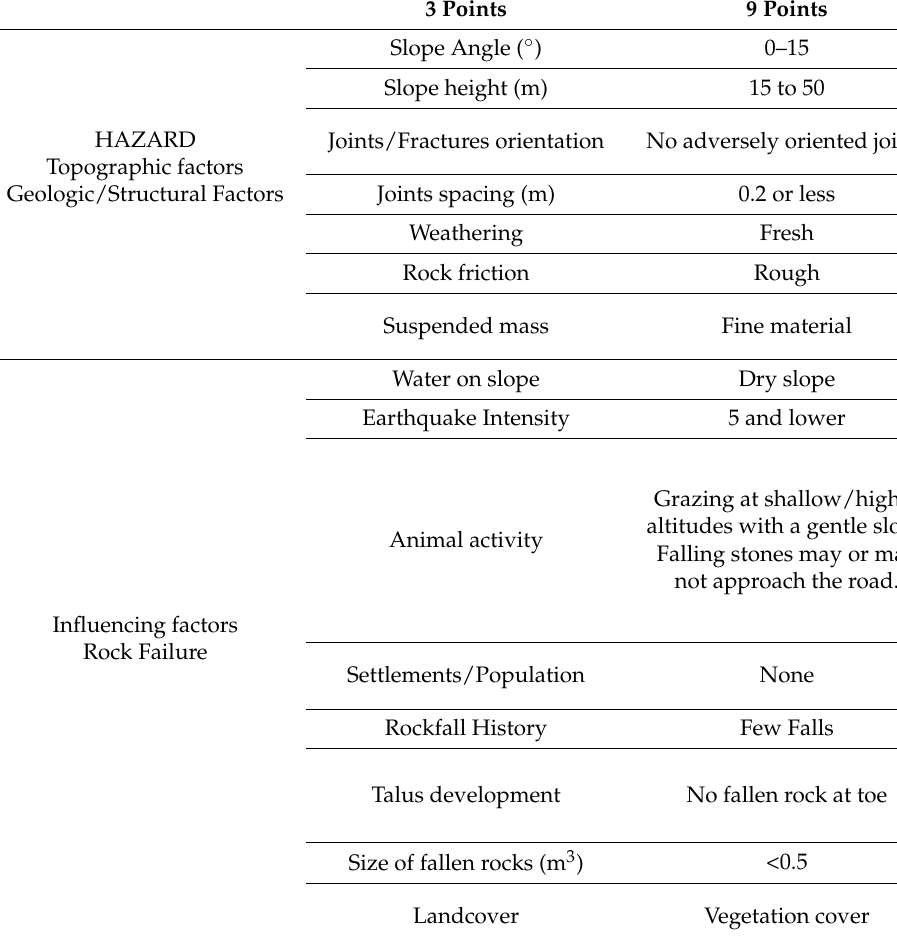
Table 2. Modified Rockfall Hazard Rating System for Pakistan (RHRSP) (After